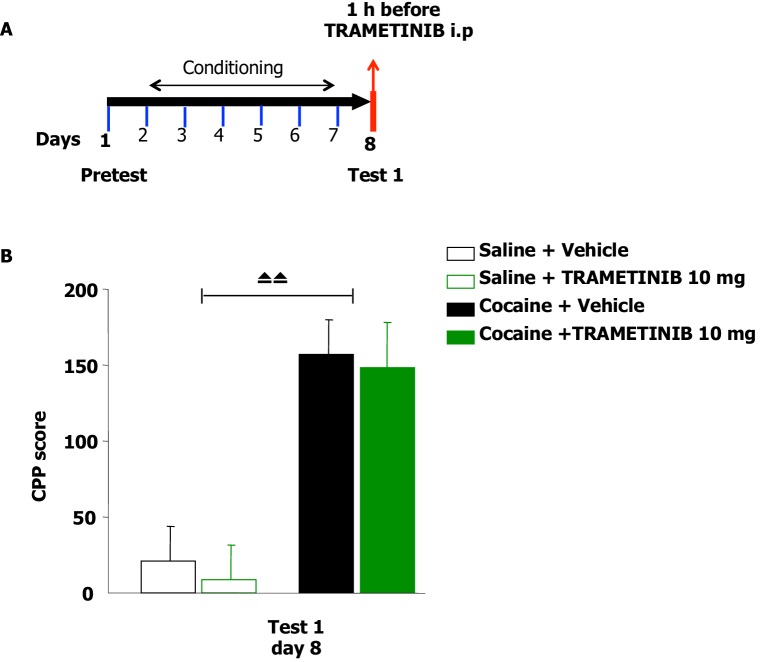
TRAMETINIB does not interfere with the retrieval of cocaine-associated memory in the conditioned place preference paradigm.(A) Experimental design of the experiment reported in B. (B) The rewarding properties of cocaine (20 mg/kg) were measured on day 8 (test 1). Mice treated with cocaine (n=24) or saline (n=18) during conditioning were further divided in 2 groups and received an acute injection of the MEK inhibitor, Trametinib (10 mg/kg, i.p.), or vehicle (10 mg/kg i.p.) 1 hr before test 1. A single administration of Trametinib did not interfere with the expression of CPP. A two-way ANOVA revealed a significant effect of cocaine F1,38 = 27.321, p<0.0001, no effect of Trametinib F1,38 = 0.164, p=0.688 and no interaction between these two factors F1,38 = 0.006, p=0.938; Bonferroni’s post-hoc, cocaine Trametinib (n=12) vs cocaine-vehicle (n=12), p>0.05; cocaine-vehicle (n=12) vs saline vehicle (n=10), p<0.01; cocaine-Trametinib (n=12) vs saline-Trametinib (n=8), p<0.01. ⏏⏏ p<0.01. Data are shown as mean with SEM.